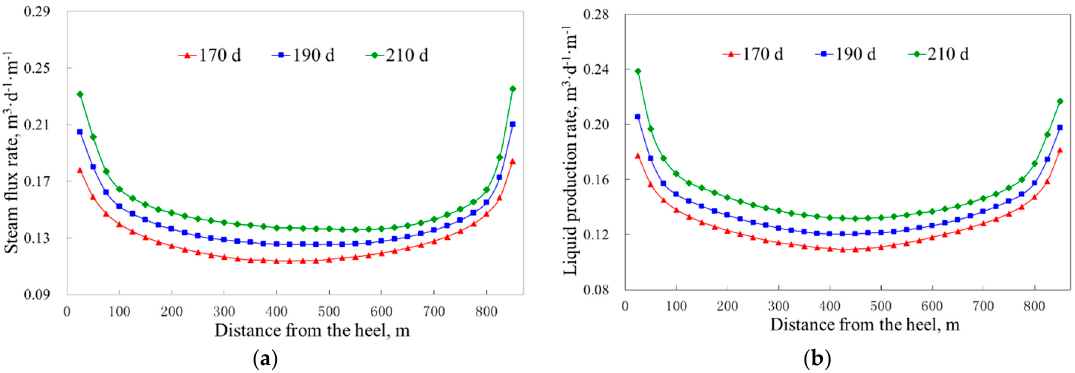
Figure 16. Effect of the injection time on the injection and production profiles: ( a ) steam flux rate; ( b ) liquid production rate.